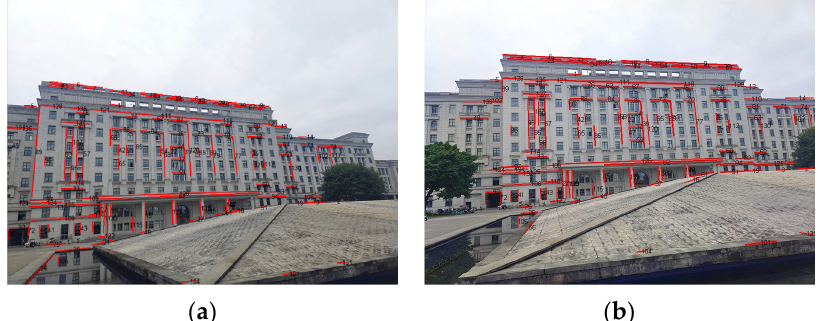
Figure 8. The rough matching results of the first scene: ( a ) the 0° image; ( b ) the 15° image.